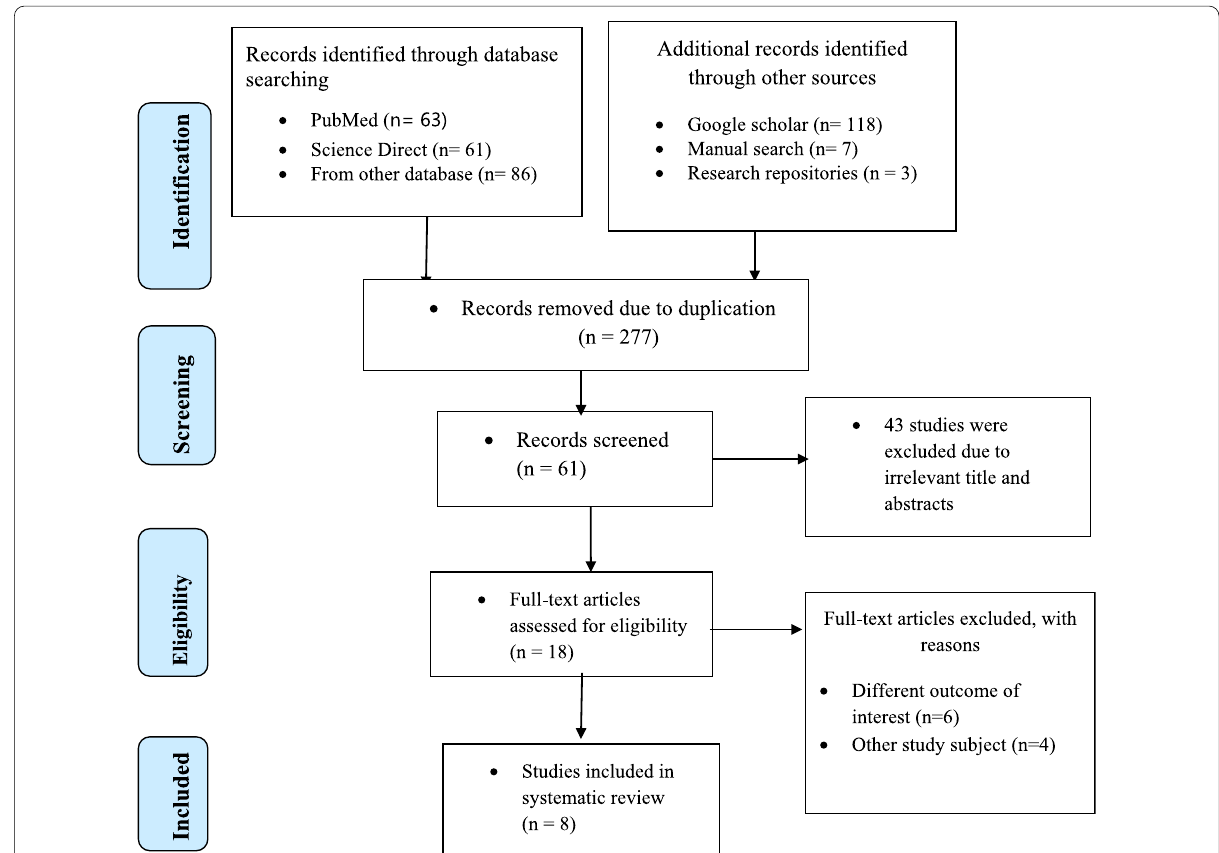
Fig. 1 Flow diagram describing the selection of studies for the systematic review and meta-analysis of prevalence and associated factors of computer vision syndrome and associated factors among computer users in Ethiopia (showing how articles were identified, screened, and included in the studies), 2021